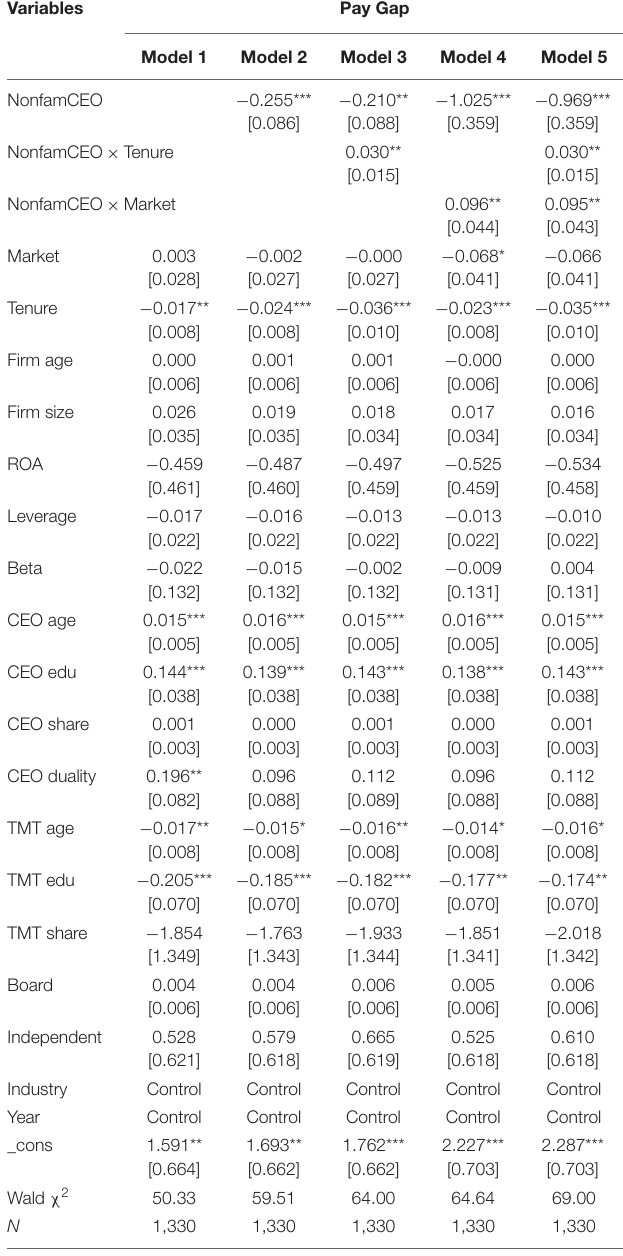
TABLE 4 | Regression model